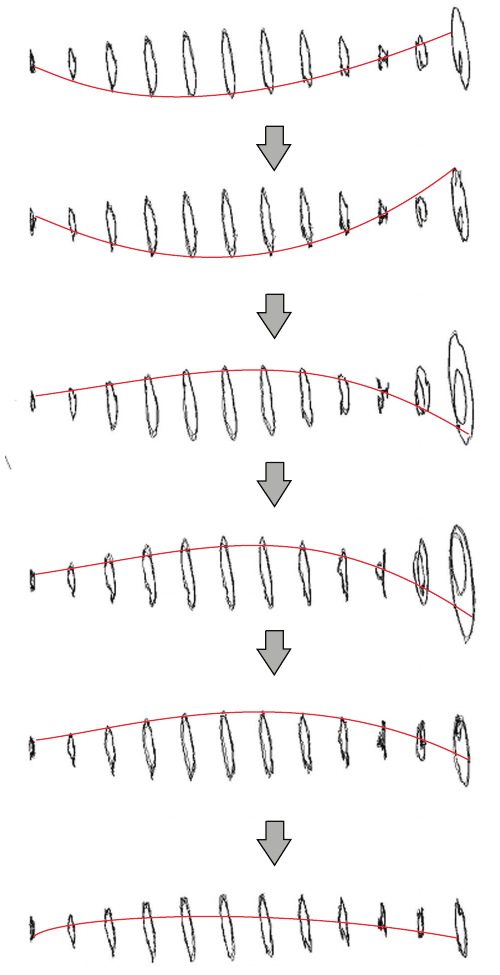
Figure 9: Orbital evolution of the flexible rotor passing through the 2X resonance of the first forward critical speed.